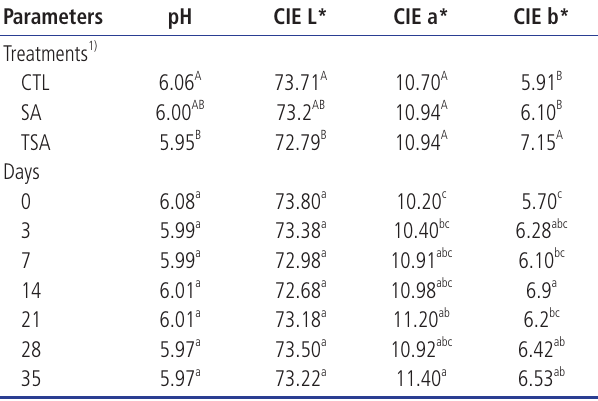
Table 1. pH and color of low-fat pork sausages wrapped with SA and TSA films